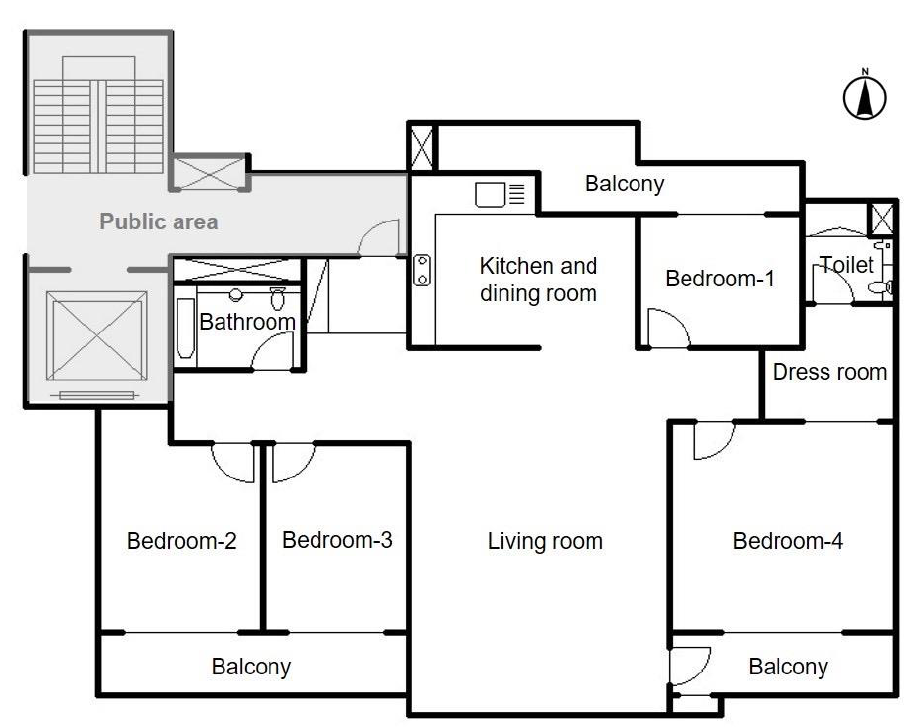
Figure 2. Floor plan of the case study residence in the high-rise apartment.